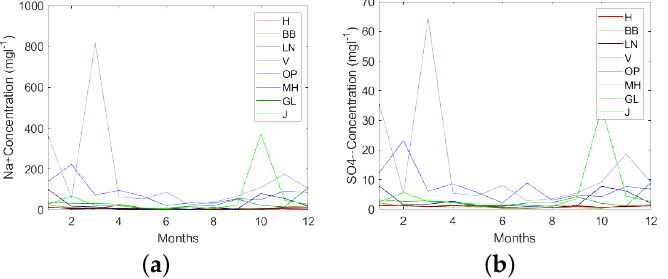
Figure 25. Maximum values reported by the stations of sodium ( a ) and sulphate ( b ) ion concentrations in rainwater collected at each